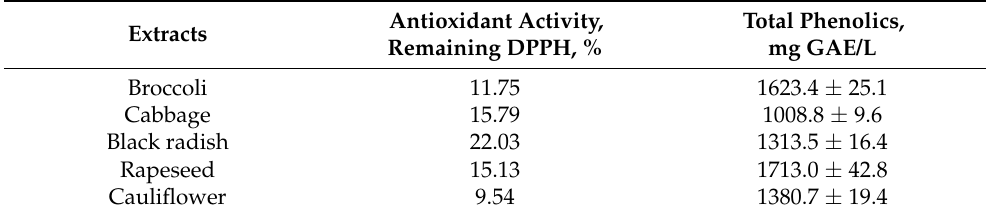
Table 1. Antioxidant activities and total phenolic content of extracts A.